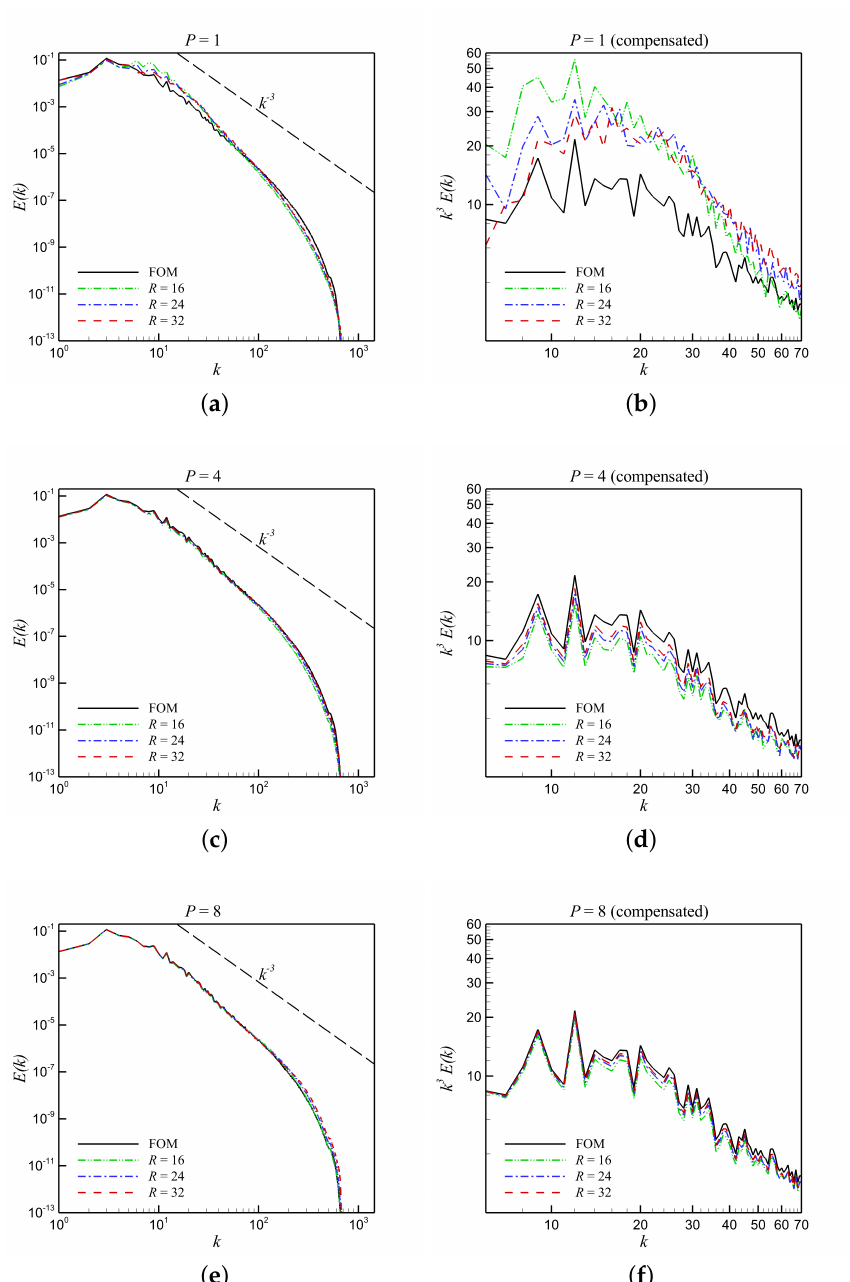
Figure 3. Energy spectra obtained from partitioned ROM with P = 1 ( a,b ), P = 4 ( c,d ), and P = 8 ( e,f ). Note that P = 1 corresponds to the standard Galerkin-based reduced order model (ROM) with global proper orthogonal decomposition (POD)